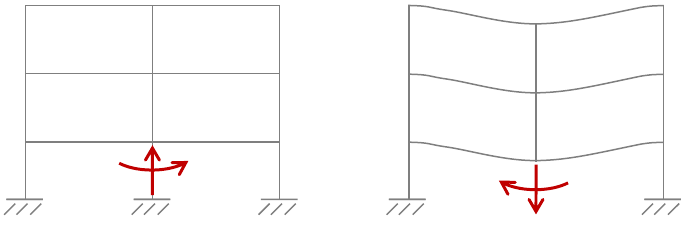
Figure 5. Stages of pulldown method.